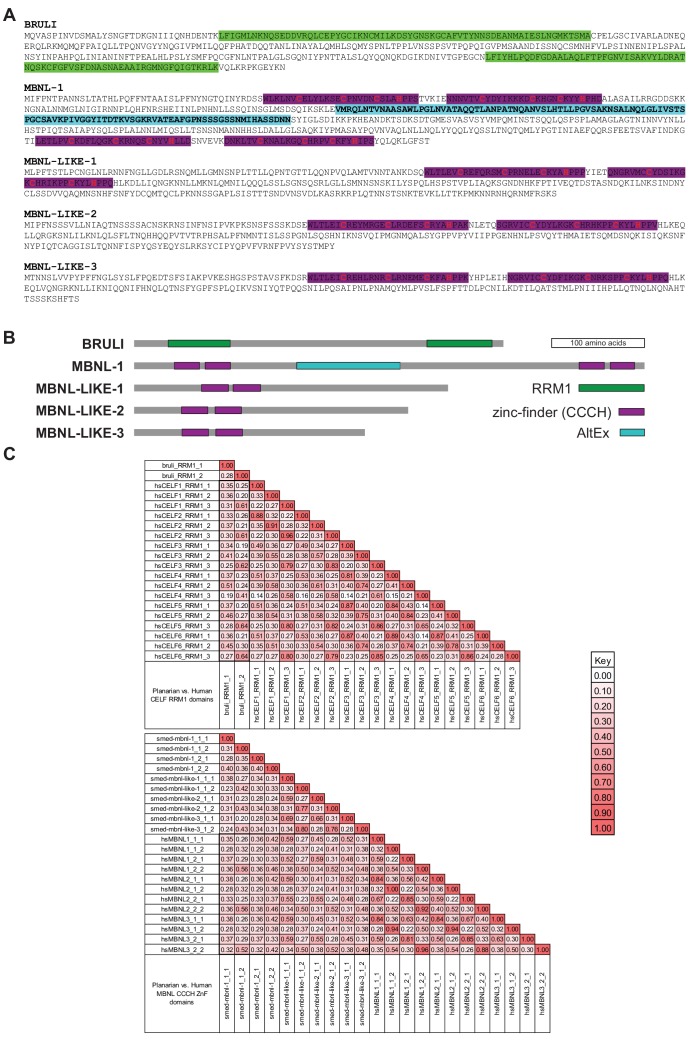
BRULI and MBNL factors domain architecture and effects on regeneration and alternative splicing.(A-B) Amino acid sequence (A) and schematization of protein domains (B) of BRULI, MBNL-1, MBNL-LIKE-1, MBNL-LIKE-2 and MBNL-LIKE-3. RRM1 domains are depicted in green and Zinc-finger domains in magenta, and their CCCH aminoacids indicated in red. The X1-inc alternative exon of mbnl-1 is depicted in cyan. (C) Sequence identity matrix between planarian and human CELF RRM1 (top) and MBNL ZnF (bottom) domains.